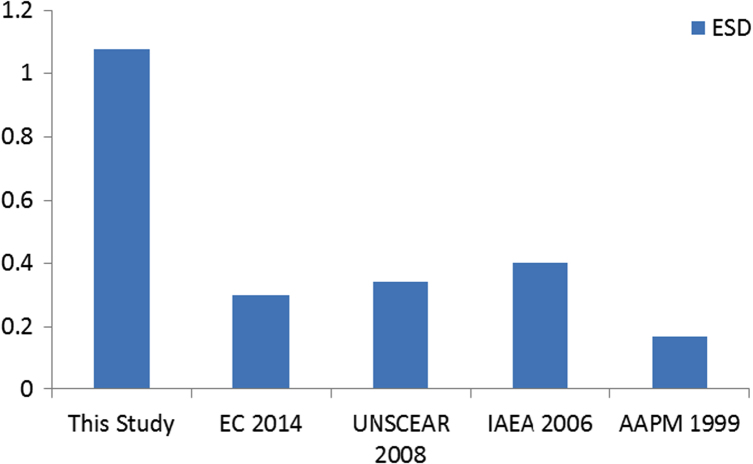
Comparison of entrance surface dose [3], [18], [19], [20].